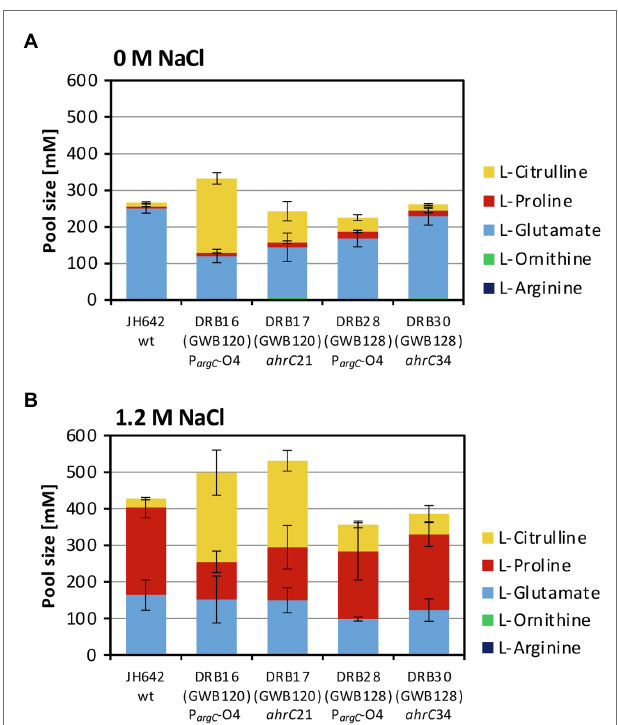
FIGURE 5 | Targeted metabolome analysis of the B. subtilis wild-type strain and selected osmostress tolerant suppressor derivatives. Metabolites from the B. subtilis wild-type (WT) strain JH642 and of four osmostress tolerant suppressor derivatives were analyzed by focusing on L-proline and on key metabolites of the L-arginine synthesis and degradation intermediates. The corresponding metabolites were assessed and quantitated form cells that had been grown in SMM to early exponential growth phase (OD 578 of about 1.5) containing either no (A) additional NaCl or (B) 1.2 M NaCl. The values given are averages and SDs of two biological replicates and each of the cellular extracts was measured in at least two technical parallels’. The precise values of the measured metabolites are documented in Supplementary Table S4 . SDs for the measurements of the indicated metabolites are indicated by bars and the statistical significands of the reported values are listed in Supplementary Table S5 .